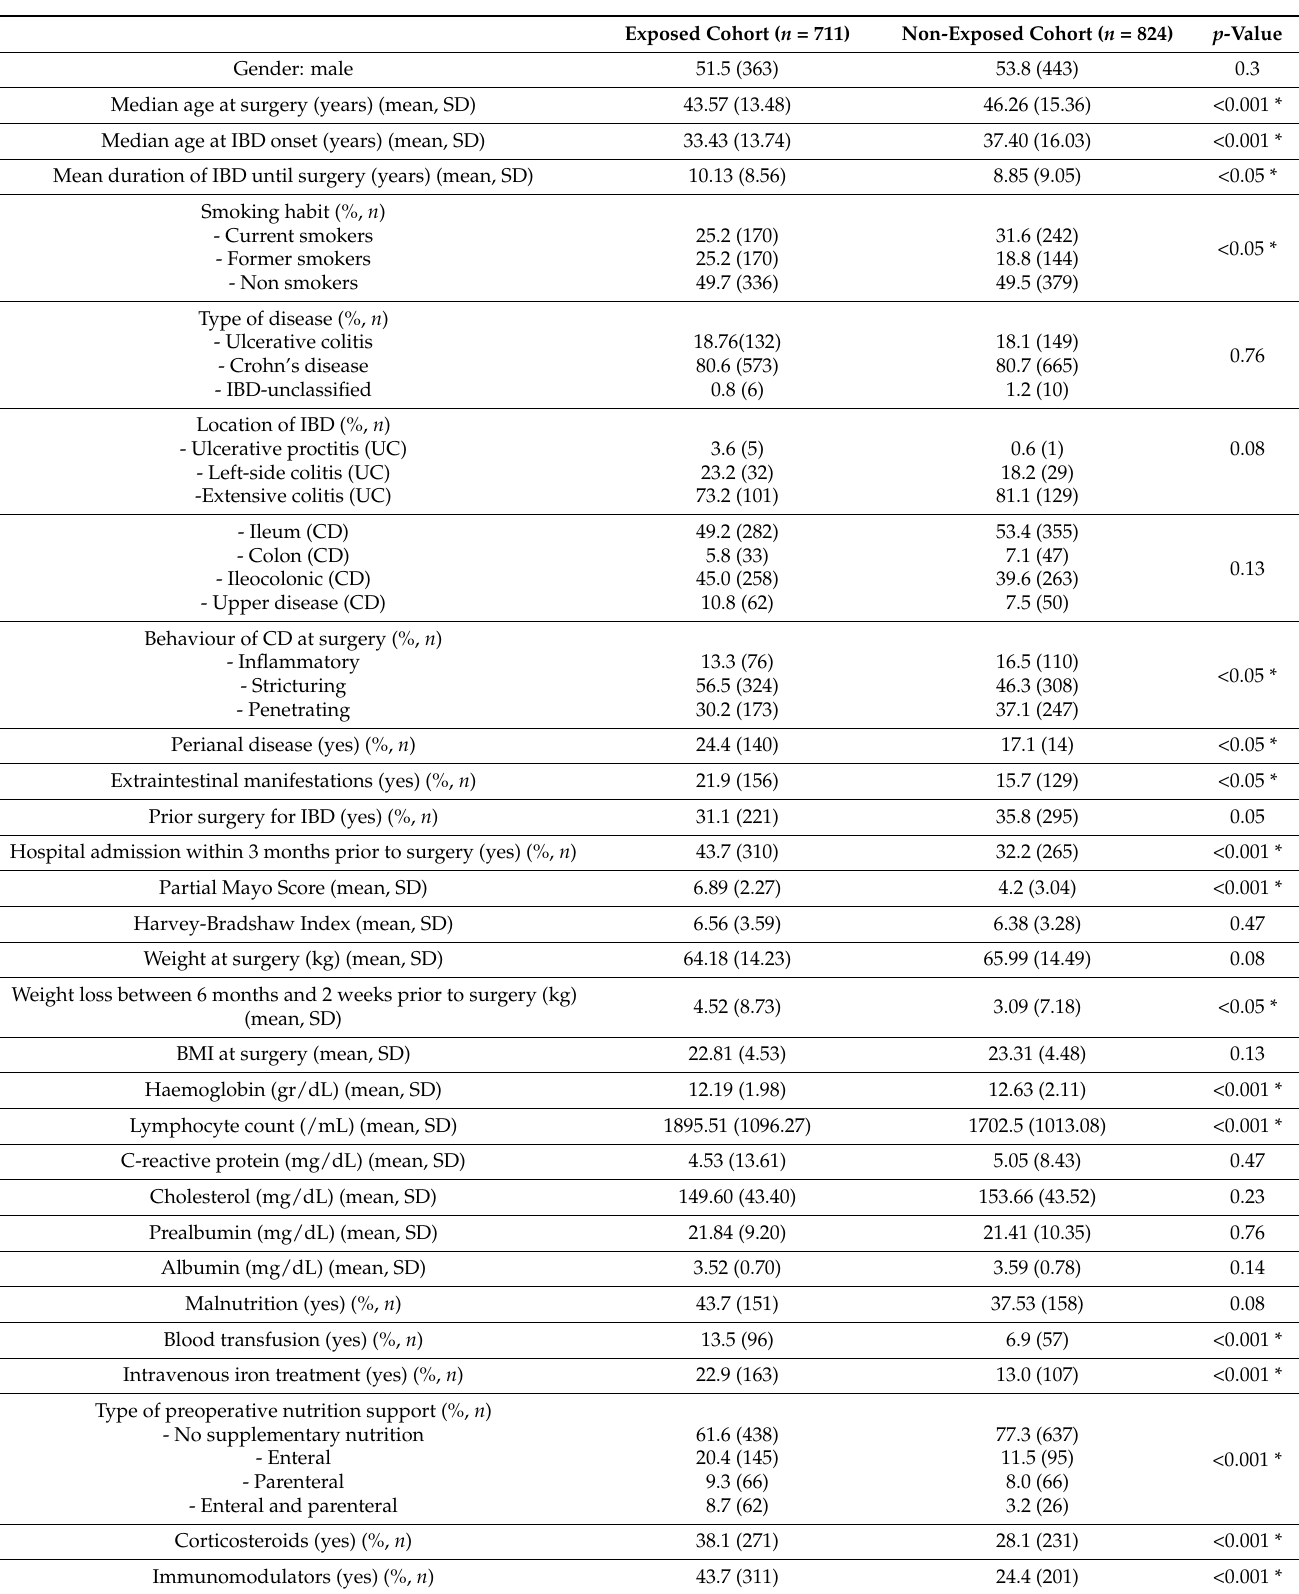
Table 1. Clinical characteristics of the surgeries according to prior exposition to biological therapy. p -values were calculated by Chi-square test, t -test or Wilcoxon-rank